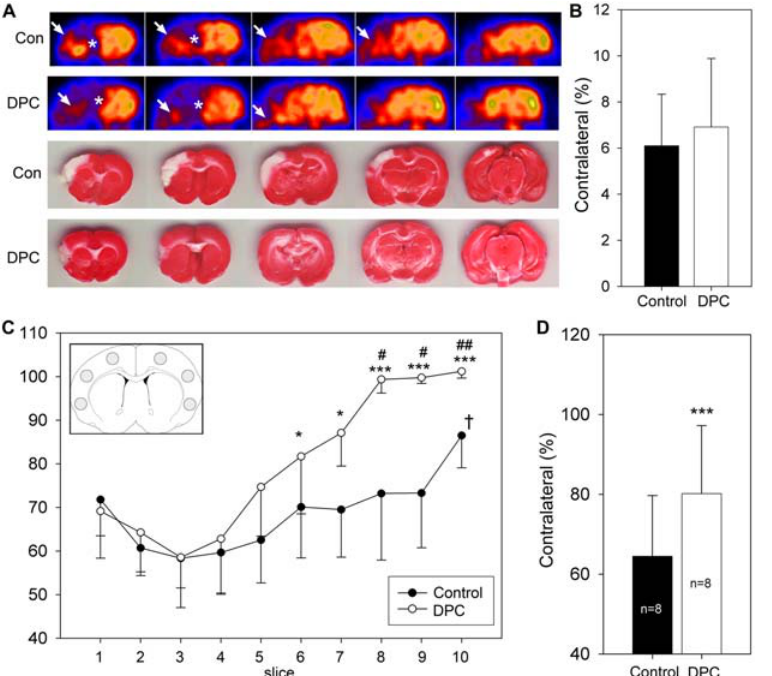
Figure 6. Effects of delayed postconditioning on FDG uptake. A. Representative PET imaging for FDG uptake and corresponding TTC staining. PET imaging was conducted 11 h after stroke; delayed postconditioning (DPC) was 6 cycles of 15 min occlusion/15 min release in the ipsilateral CCA. In the ischemic core, no apparent FDG uptake was detected (* indicated by the dark region defined as the ischemic core); in the penumbra, the signal was weaker than that in the contralateral hemisphere. There is a non-specific signal caused by the skin incision outside the brain (arrow). Rats were euthanized 2 d after stroke for TTC staining. The infarct region corroborates with the region with reduced FDG uptake. B. Delayed postconditioning (DPC) did not affect ischemic core sizes measured from PET imaging. PET images from a total of 10 levels, with a 1 mm distance between adjacent levels, were selected. The core area was measured and normalized to the whole contralateral hemisphere and expressed as a percentage; an average value from all measured levels is presented. There was no difference in the core size between rats receiving control ischemia and delayed postconditioning, suggesting that delayed postconditioning did not change FDG uptake in the ischemic core. C. DPC improved FDG uptake. The optical densities of Region of interest (ROI) in the selected 10 coronal slices from rostral (level 1) to caudal (level 10) were measured; ROIs are indicated on the inserted diagram (right corner). Optical densities in three ROIs (1 mm diameter circle) in the cortex from the ipsilateral and contraleral cortex were measured. The average density in the ipsilateral hemisphere was divided by that in the contralateral hemisphere and expressed as a percentage. FDG uptake is significantly higher in the caudal slices (slices 5–10) vs. rostral slices (slices 1– 4) in rats receiving DPC; it is also significantly higher in slice 10 than in other slices in rats receiving control ischemia. DPC improved FDG uptake in slices 5 to 10 compared with corresponding slices in control rats. *, *** vs. corresponding time points in control rats, P , 0.05, 0.001, respectively. { vs slice 2,3,4,5, P , 0.05;. # vs. slice 1,2,3,4, P , 0.01; ## , vs. slice 1, 2, 3, 4, 5, P , 0.05 (Anova on Ranks followed with Dunn’s test). *, *** P , 0.05, 0.001, vs corresponding slices in the DPC groups. D. Square means of overall values from all 10 slices. DPC significantly improved overall FDG uptake. *** vs. control ischemia, P ,